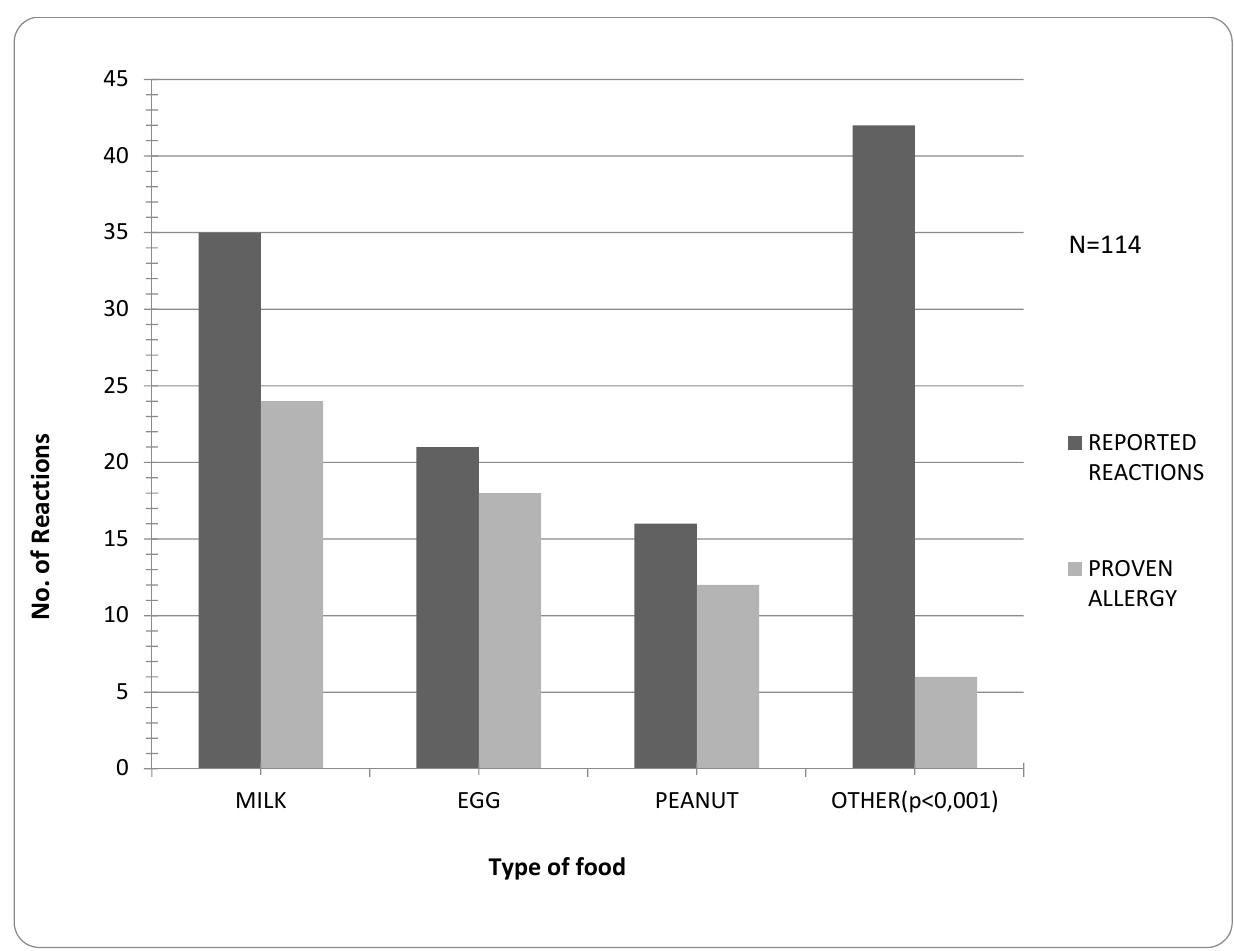
Figure 2. Frequency of reported reactions versus proven allergy to types of